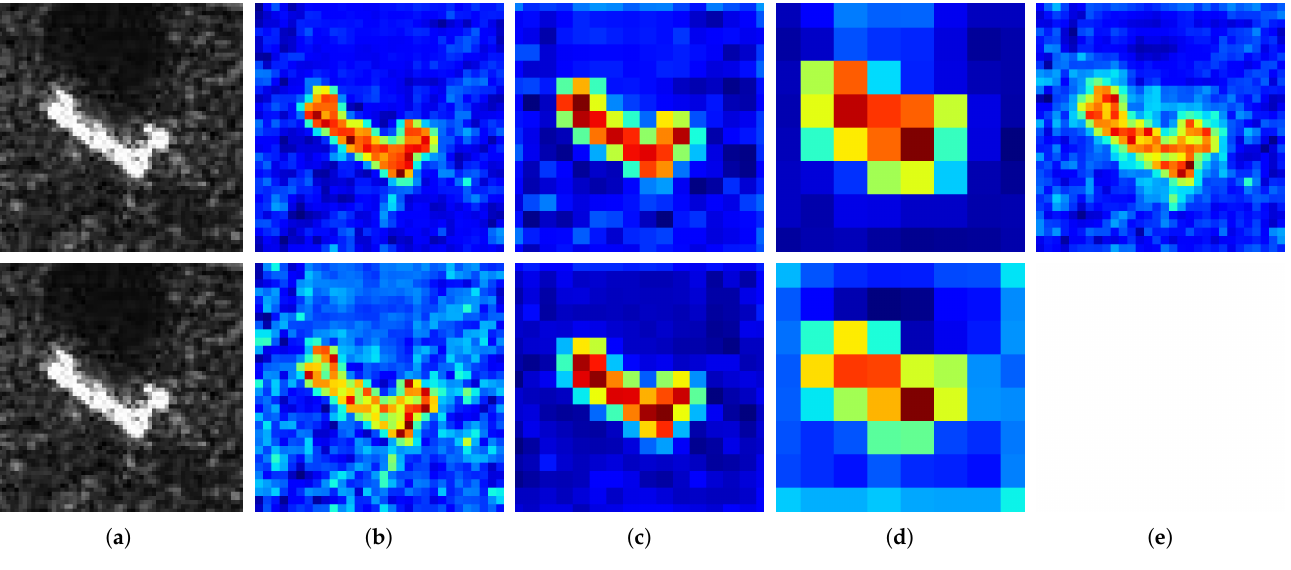
Figure 9. The comparison of feature maps between our model and the baseline model. The first row shows the feature maps of our method and the second row the feature maps of the baseline method: ( a ) the input image of 2S1, ( b ) the feature maps on the first convolution layer, ( c ) the feature maps on the second convolution layer, ( d ) the feature maps on the third convolution layer, ( e ) the feature map after multi-scale feature fusion.